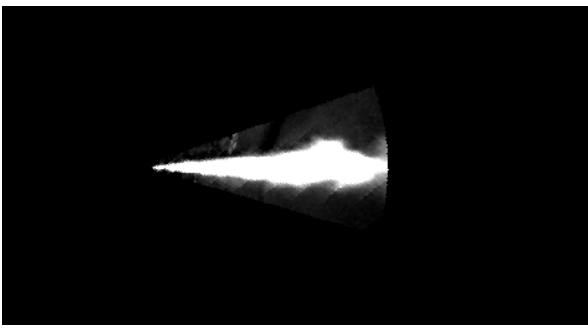
Figure A6. Illustration of the relative position of the pie-shaped mask and the spray to be selected. Energies 2020 , 13 , x FOR PEER REVIEW